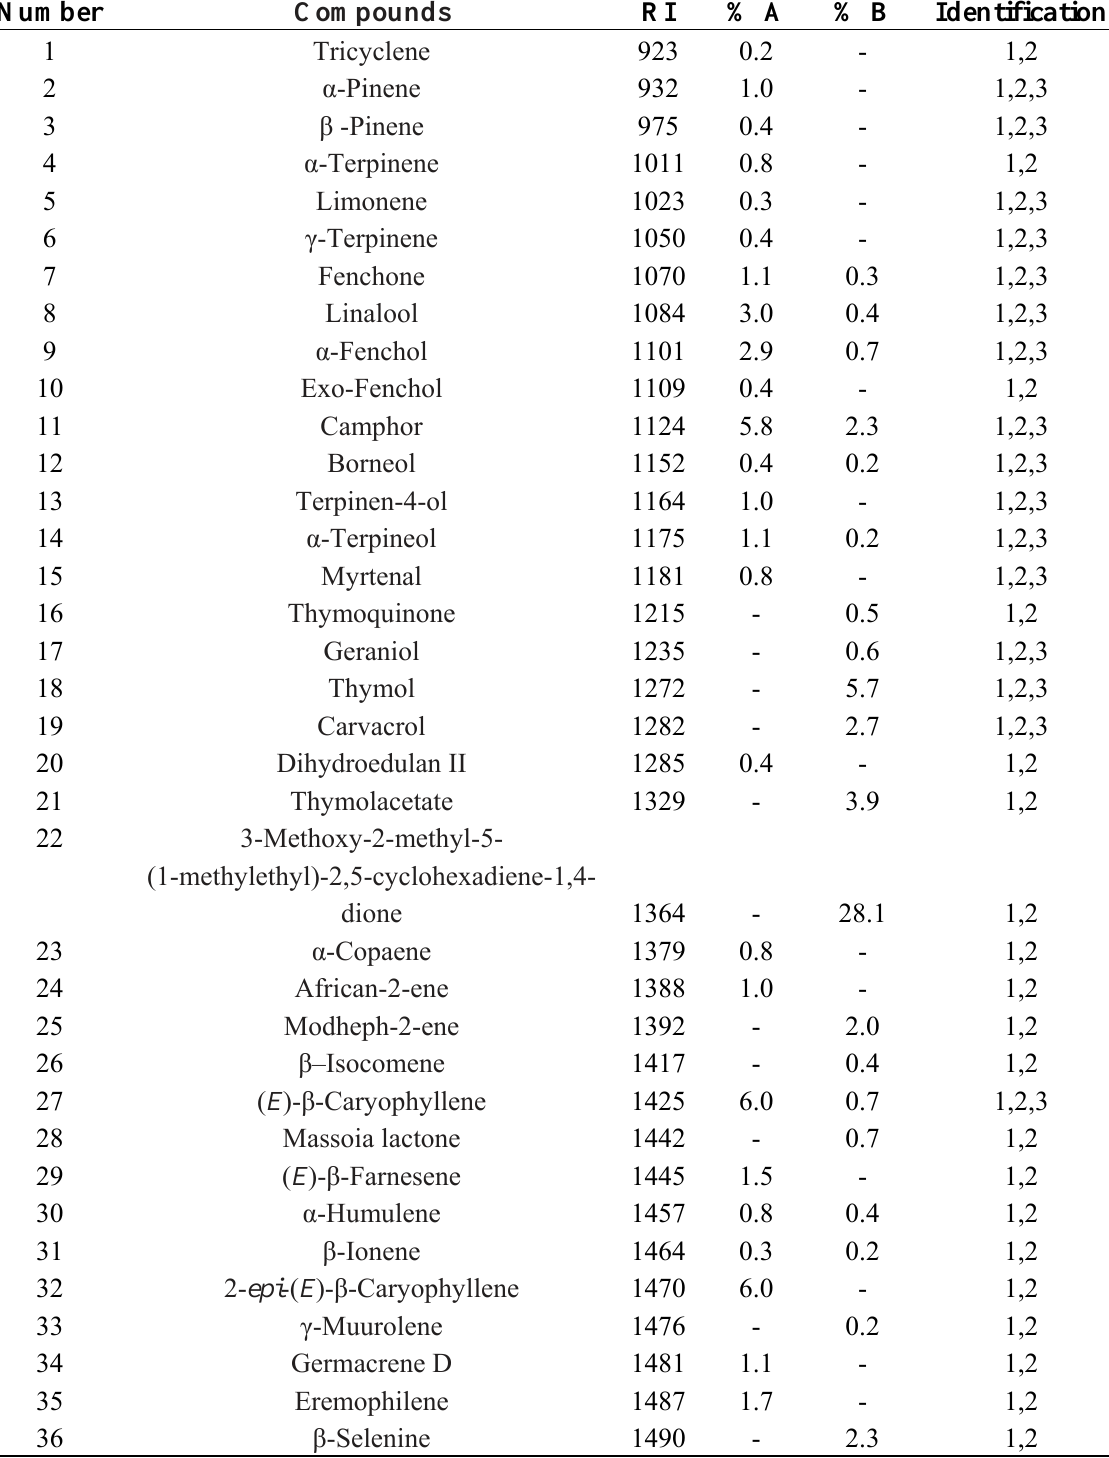
Table 1. Chemical composition of the essential oils of E. arabicus (A) and L. decurens